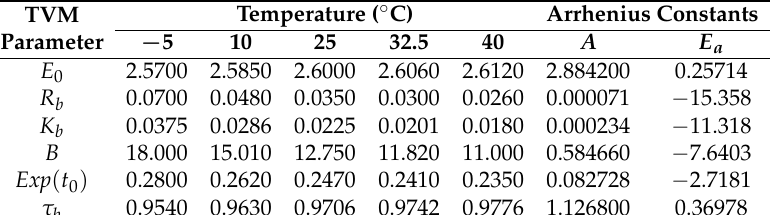
Figure 8. Experimental vs. analytical results. Table 5. Temperature-Dependent Voltage Model (TVM) parameters at different temperatures.